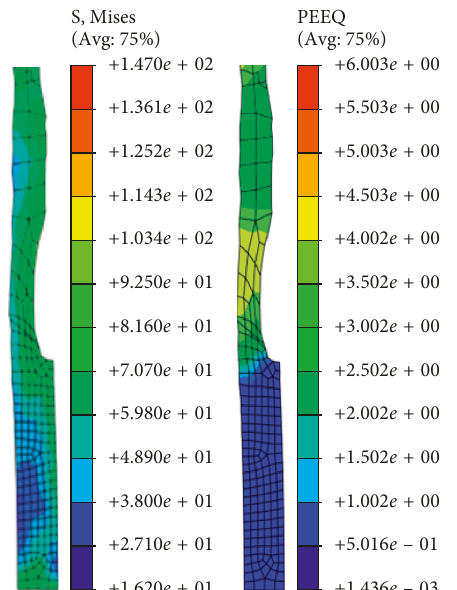
Figure 9: Mises stress diagram and equivalent strain diagram of the latitudinal ribs ( α � 17 ° , Ψ � 43%, and f �